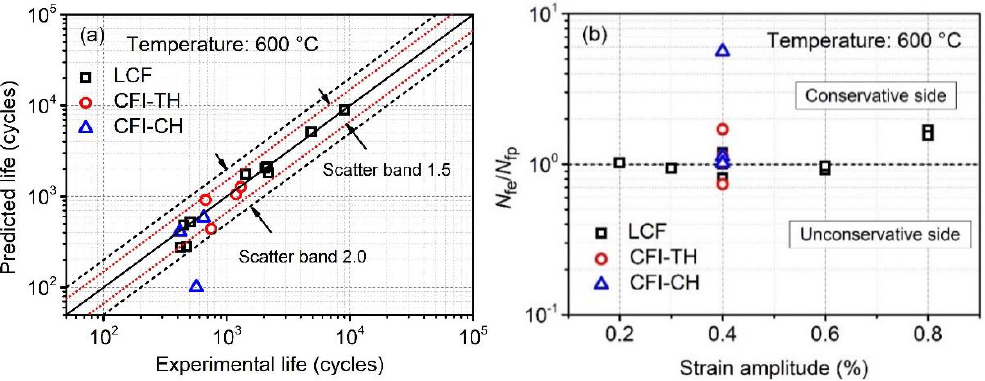
Figure 8. ( a ) Comparison between experimental life and predicted life using FS model, ( b ) the ratio of experimental life to predicted life versus different strain amplitudes.